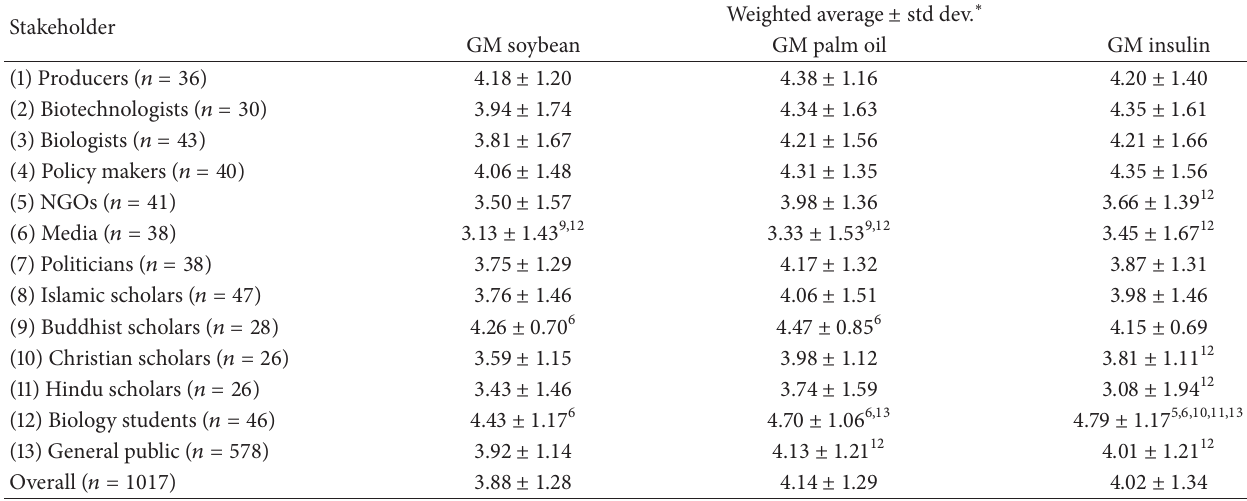
Table 7: Weighted average and post hoc test results for risk acceptance of GM foods and GM insulin.